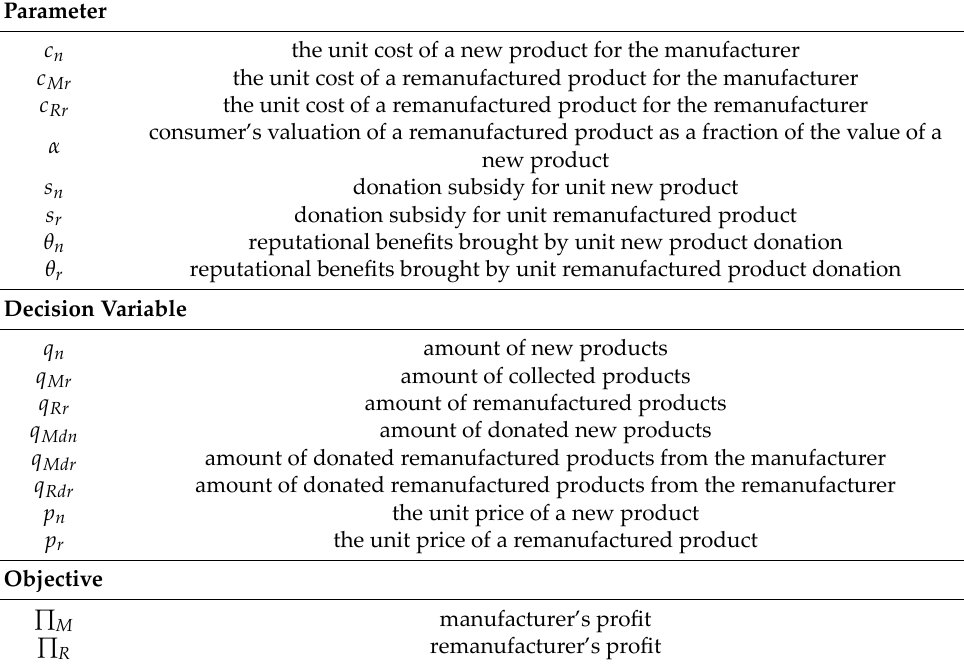
Table 2. Notation